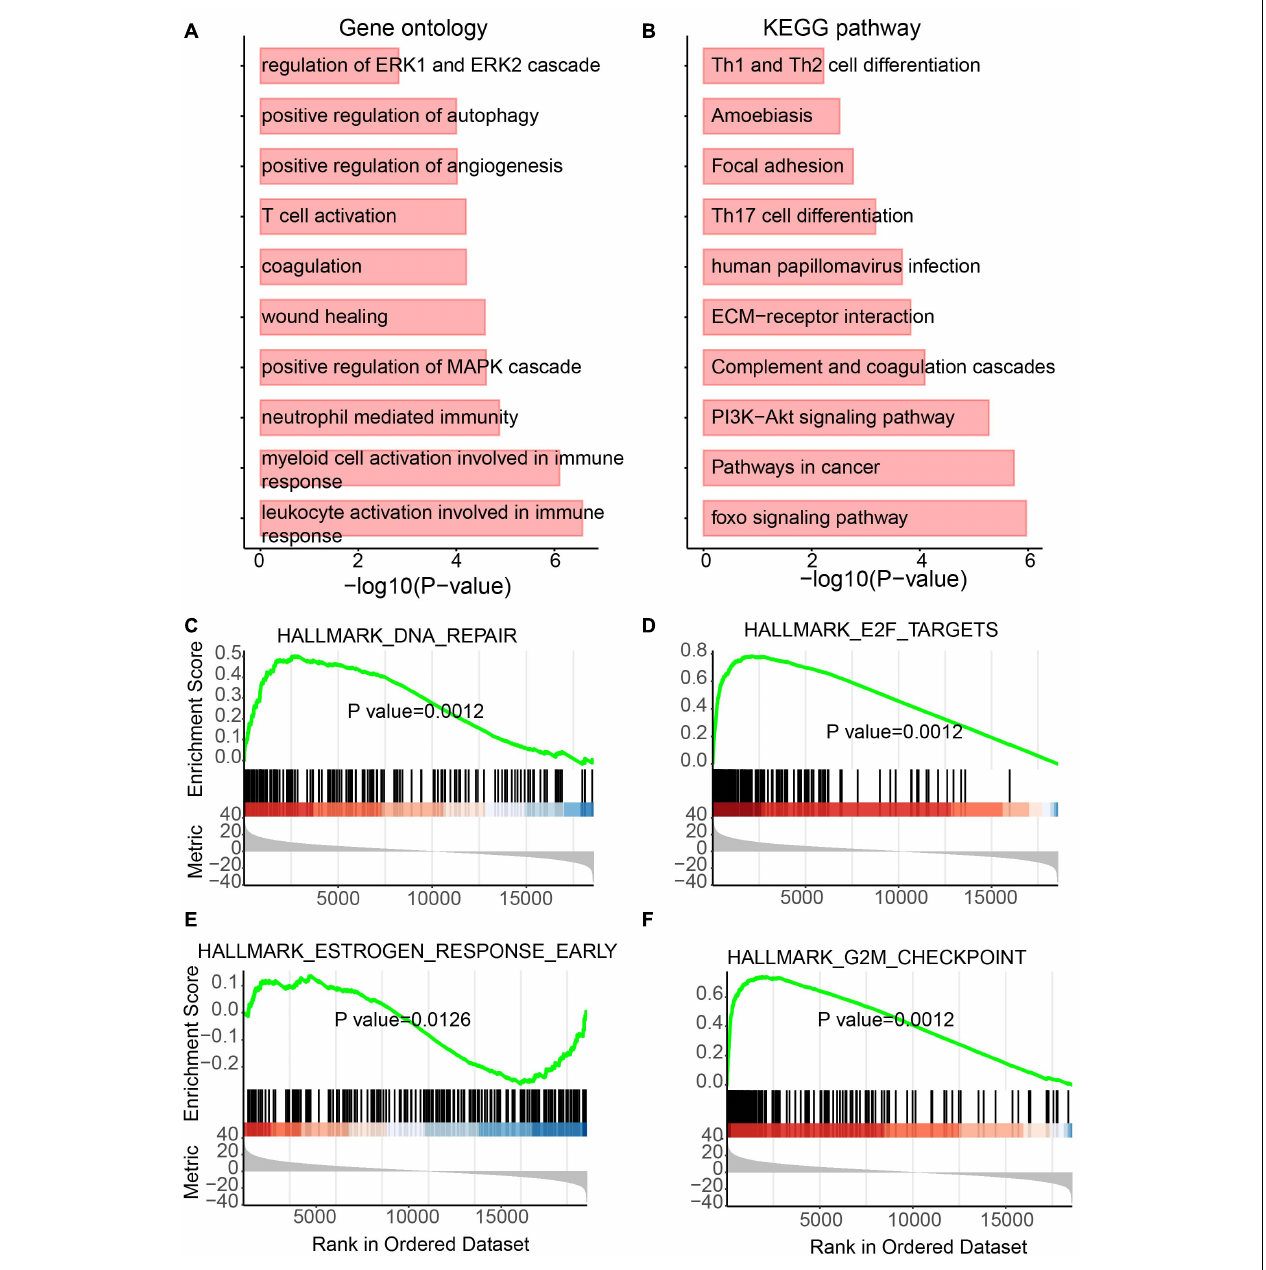
FIGURE 5 | Functional enrichment analysis for differentially expressed miRNAs. (A) Enriched GO terms. (B) Enriched KEGG pathways. (C–F) Results of GSEA